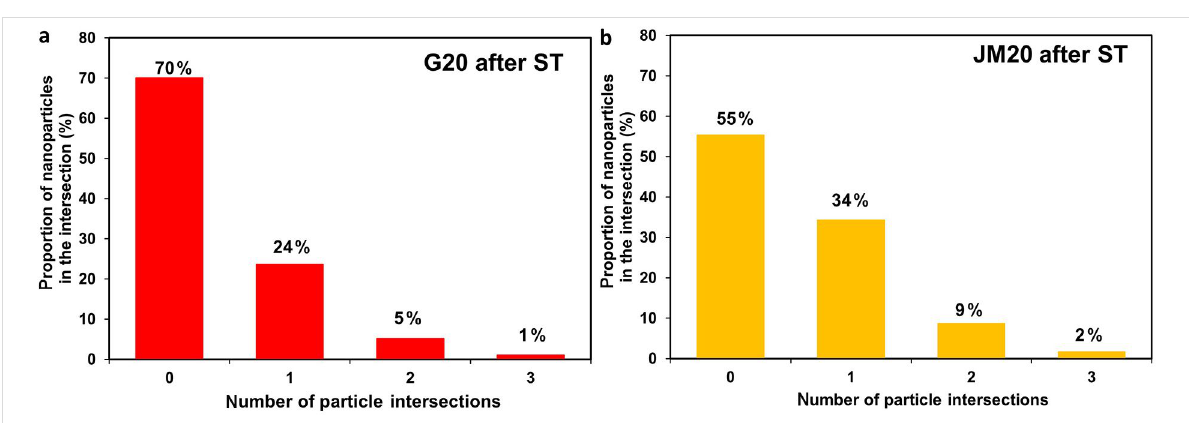
Figure 9: Histograms of nanoparticle distribution by the number of intersections with "neighbors" for the catalysts G20 (a) and JN20 (b) after the stress test.